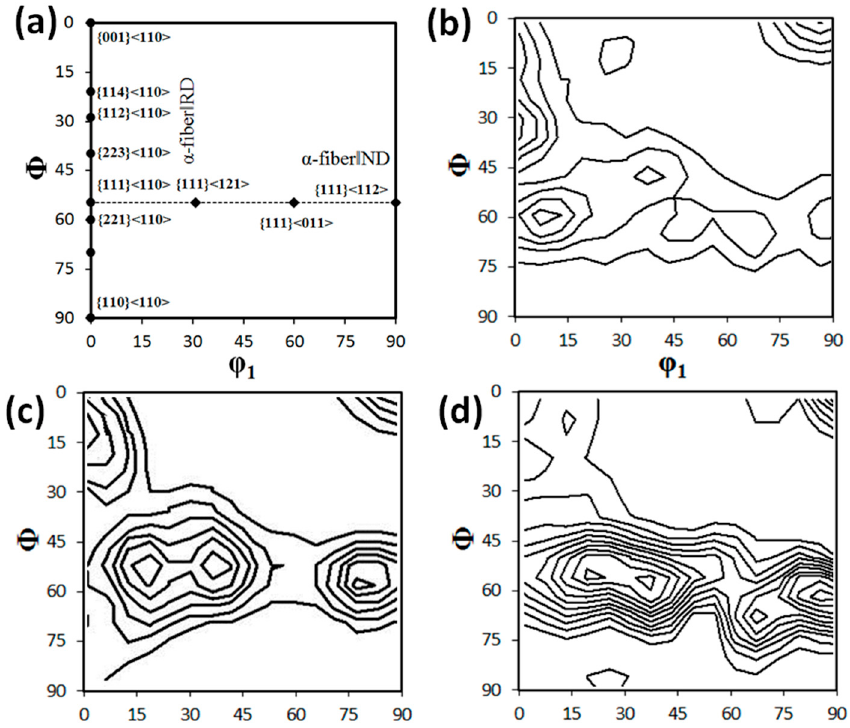
Figure 6. φ 2 = 45° orientation distribution function (ODF) sections of ( a ) the ideal body-centered cubic fibers and under conditions of ( b ) dry, ( c ) lubricating oil, and ( d ) polyphosphate lubricant.